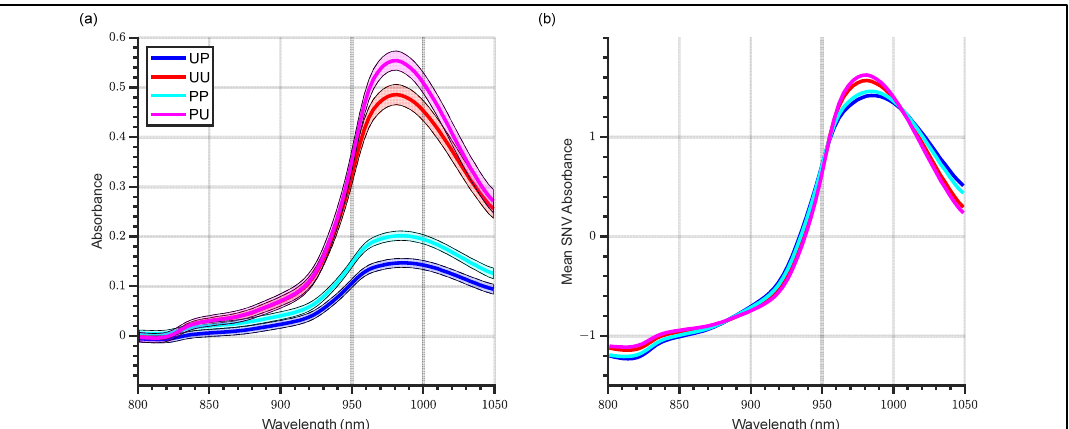
Figure 3. Absorbance spectra (800–1050 nm) of kiwifruit for unpeeled polarized (blue), unpeeled unpolarized (red), peeled polarized (cyan) and peeled unpolarized (magenta) for ( a ) Raw absorbance with filled areas representing mean ± std and ( b ) Mean SNV absorbance for each configuration.